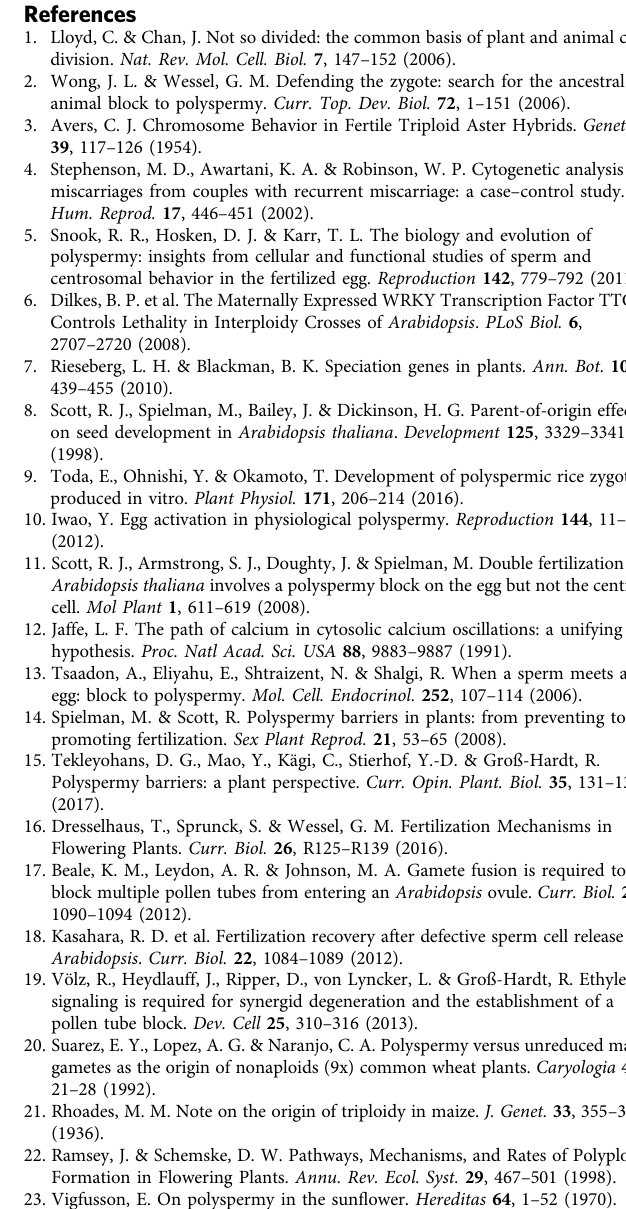
total of 58 petals. Figure 3k: Silique analysis was performed twice and the experiment was conducted blind. In total 19 wild-type siliques ( n = 19) corre- sponding to 516 seeds and 39 siliques of triparental plants ( n = 39) corresponding to 1016 seeds were